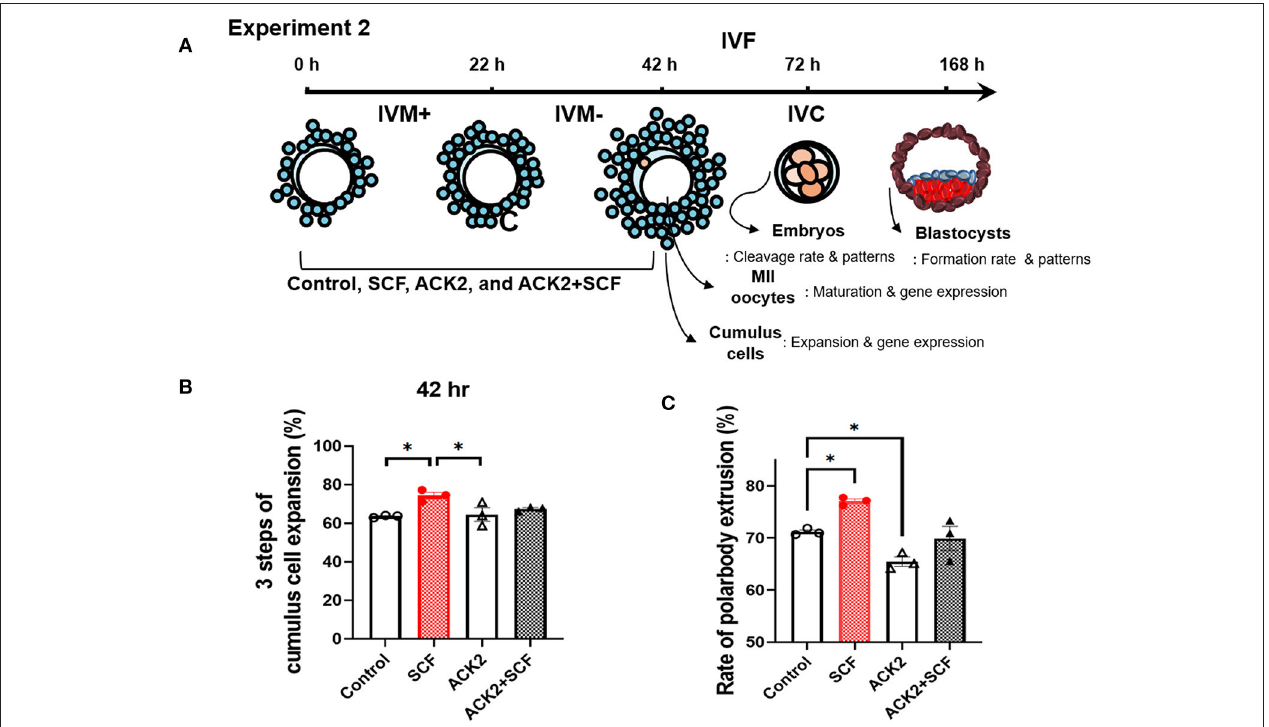
FIGURE 4 | Effect of stem cell factor (SCF)/c-kit signaling during porcine in vitro maturation (IVM) on cumulus expansion and nuclear maturation of porcine cumulus-oocyte complexes (COCs). (A) Experimental design to examine the effect of SCF/c-kit signaling for porcine oocytes and subsequent developmental competence after in vitro fertilization (IVF). IVM + and IVM– indicate that incubation was in media with or without the eCG hormone, respectively. Inhibition of KIT by ACK2 in porcine oocytes. (B) Quantified three steps of cumulus cell expansion after 42h of IVM supplemented with SCF and/or ACK2. (C) Quantified rate of polar body extrusion after 42h of IVM supplemented with SCF and/or ACK2. For all graphs, the value represents the mean ± SEM. Asterisks indicate statistical significance (* p < 0.05). Statistical significance was determined by one-way ANOVA. The experiments were performed in triplicate.